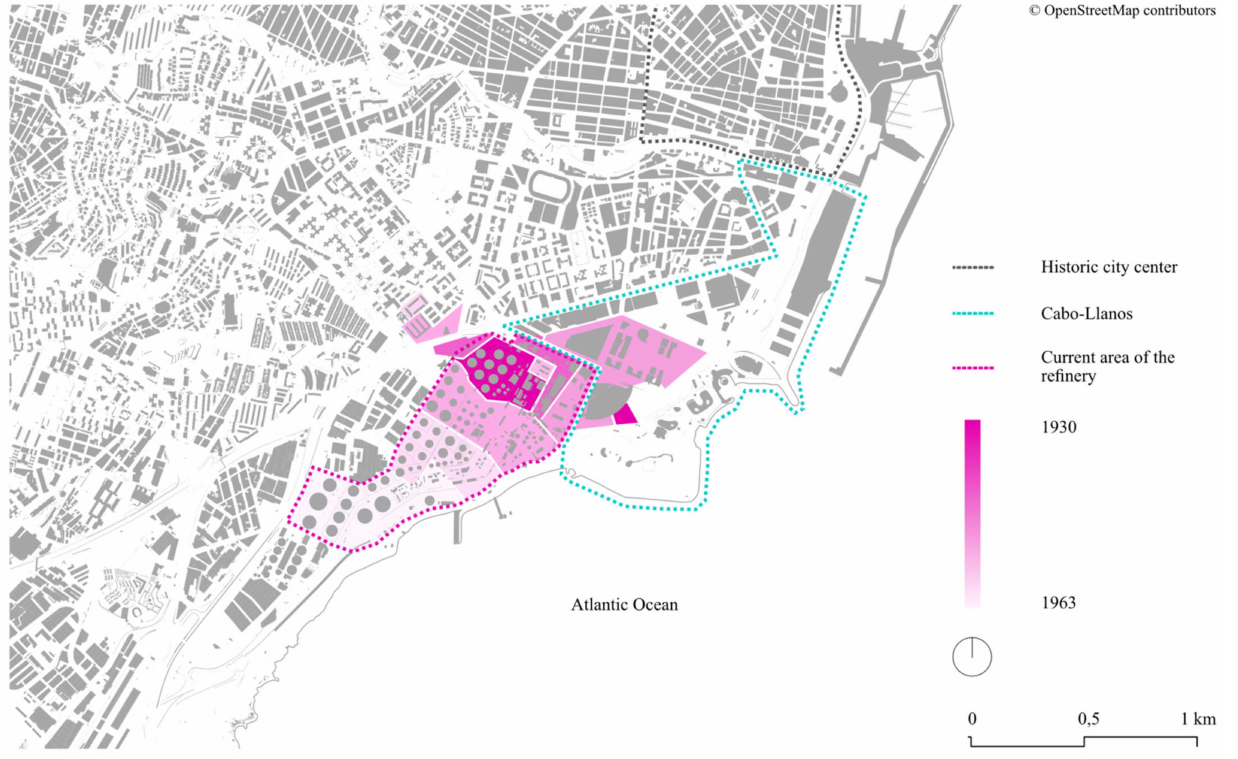
Figure 6. Expanding and dismantling the oil refinery on Tenerife. Own elaboration based on Open Street Map and Geofabrik GmbH [33] and Arencibia de Torres